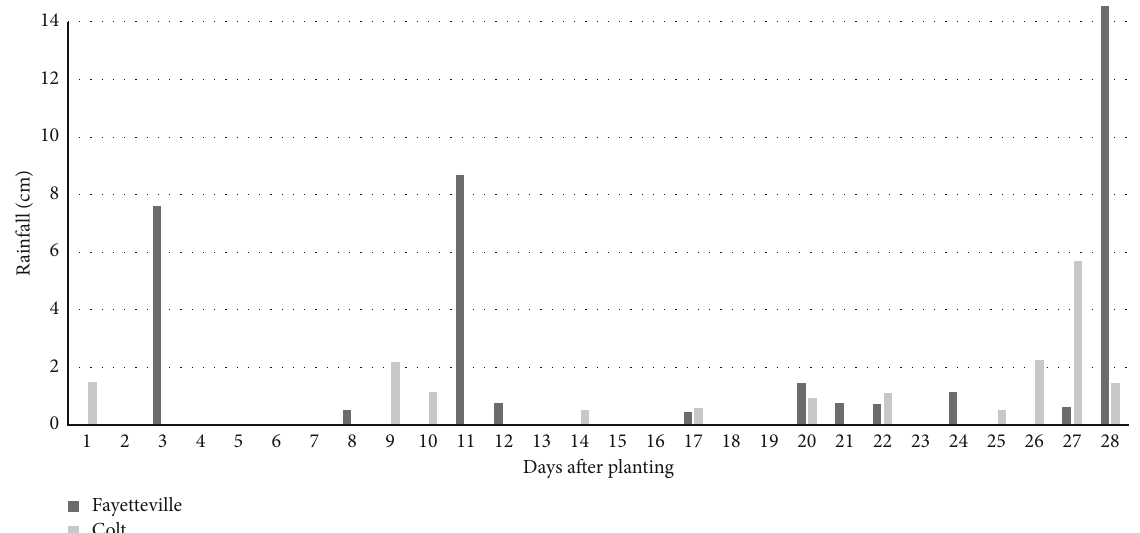
Figure 1: Precipitation history 28 days following planting of irrigation experiment conducted at Fayetteville and Colt, AR, in 2019. Table 1: Effects of irrigation regime, application timing, and rating date to injury analyzed as a repeated measures analysis for the irrigation experiments conducted in Fayetteville and Colt, AR, in 2019.